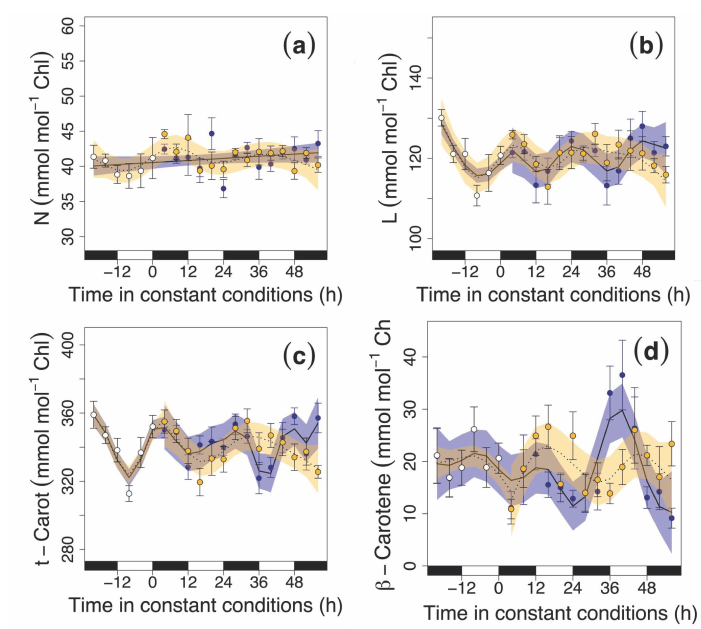
Figure 4. Carotenoids in rocket leaves during the last cycle of the entrainment phase (white circles) and under continuous darkness (blue circles) and continuous illumination conditions light (yellow circles): ( a ) neoxanthin expressed on a chlorophyll basis (N; mmol mol − 1 Chl), lutein expressed on a chlorophyll basis (L; mmol mol − 1 Chl), ( b ) total carotenoids expressed on a chlorophyll basis (t-Carot; mmol mol − 1 Chl), ( c ) and β -carotene expressed on a chlorophyll basis ( β -Car; mmol mol − 1 Chl), and ( d ). Black and white rectangles on the x -axis represent subjective night and day, respectively (that is, when leaves would have experienced nighttime or daytime conditions). Time zero represents the time when constant conditions started. Temporal patterns were examined with the generalized additive model (GAM) fitted with an automated smoothness selection [31]. Shaded areas indicate the 95% CI of the fitted GAM. Values are the mean of 10 replicates ± S.E.